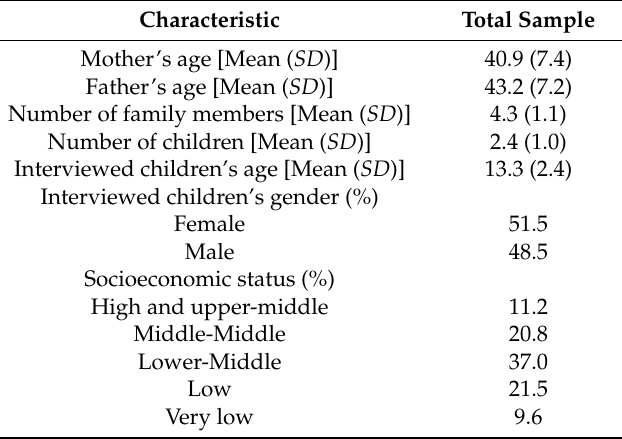
Table 1. Sample characteristics (n =